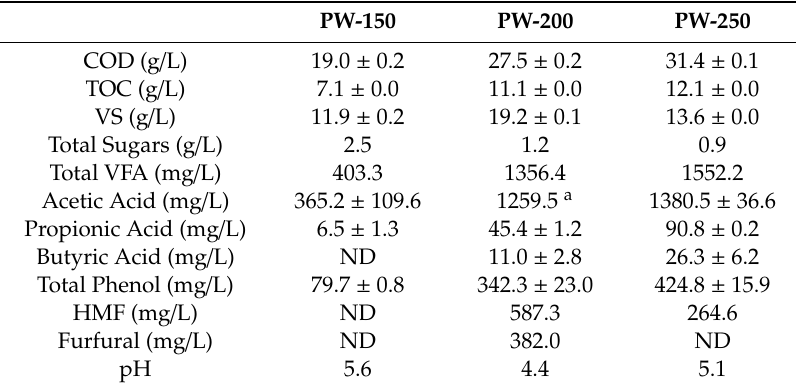
Characterisation of process water fraction from water hyacinth hydrothermal carbonisation